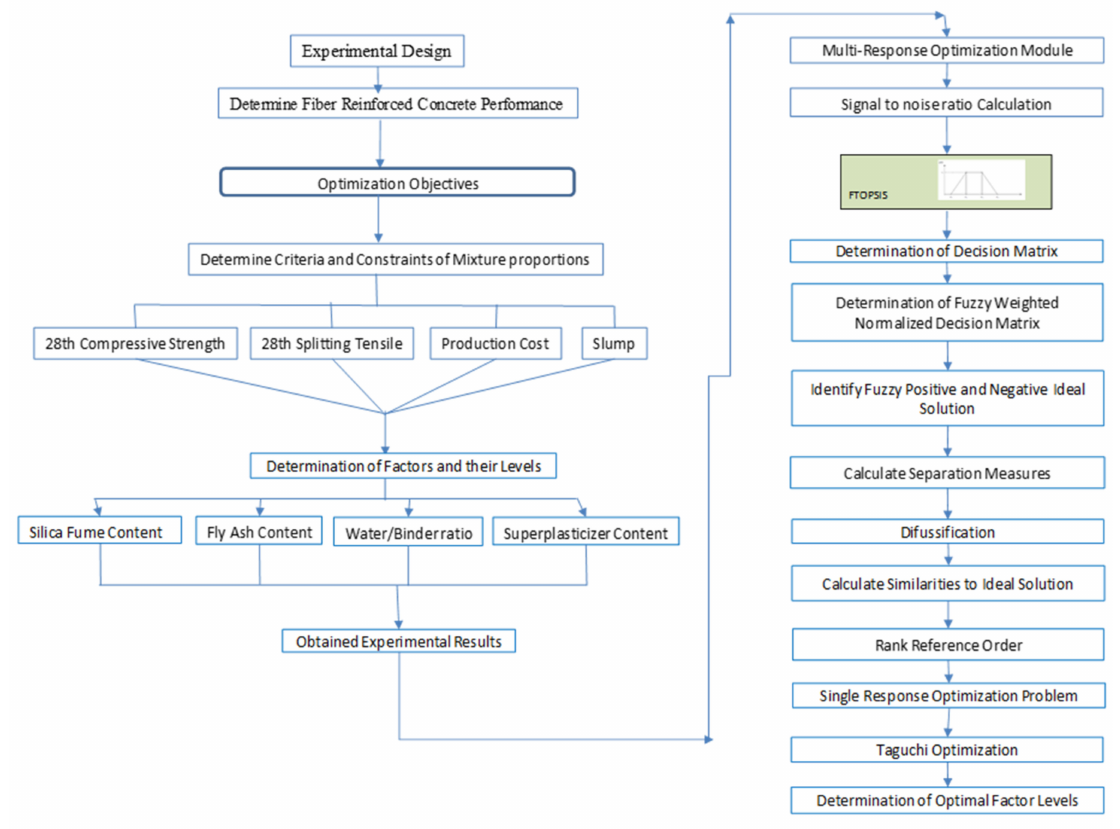
Figure 3. Proposed framework of the fuzzy TOPSIS-based Taguchi model.